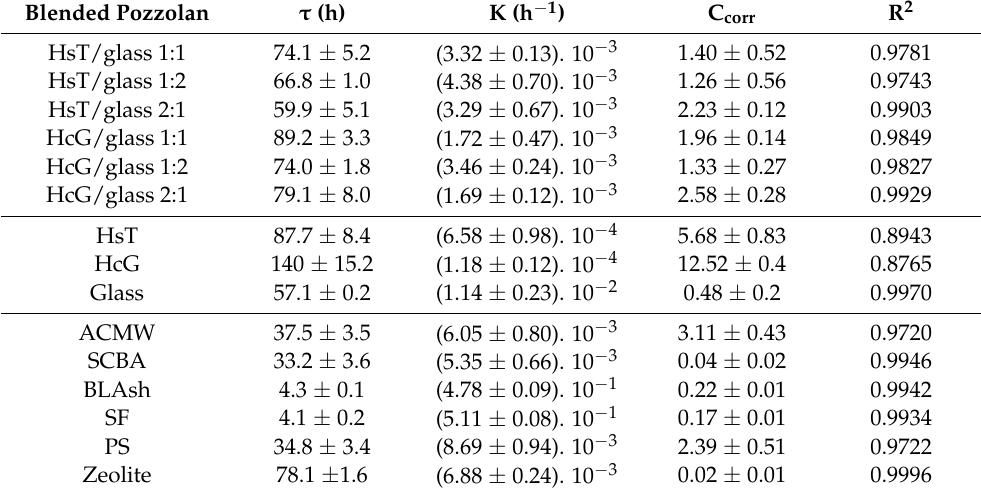
Table 3. Reaction rate constants (K), τ parameter, C corr parameter and coefficient of multiple determination (R 2 ) for blended pozzolans (Activated Coal Mining Waste = ACMW; Sugar Cane Bagasse Ash = SCBA; Blash = Bamboo Leaf Ash; Silica Fume = SF; Paper Sludge Ash = PSA; Zeolite).